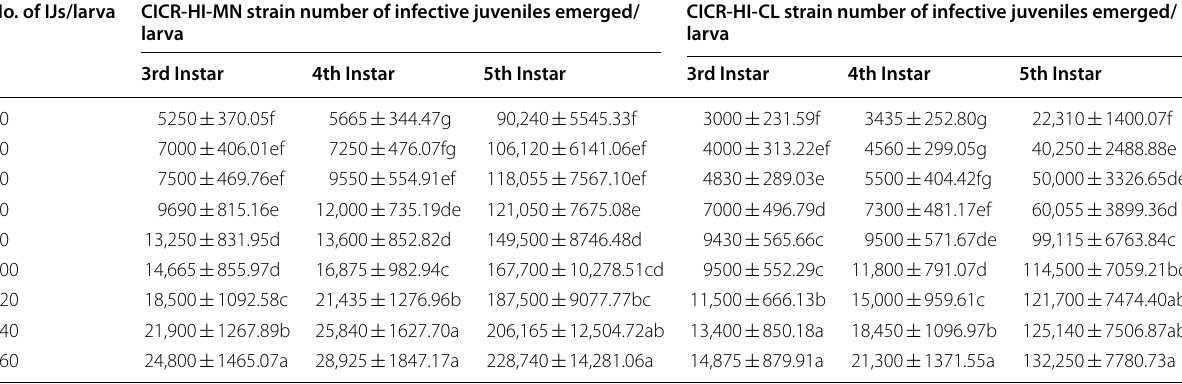
Values in the table indicate mean reproductive potential ( across concentrations within same larval instar using WASP software in completely randomized design at P